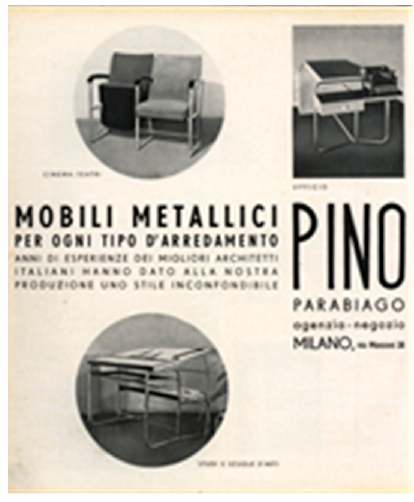
Figure 22. Advertising Pino Parabiago company.